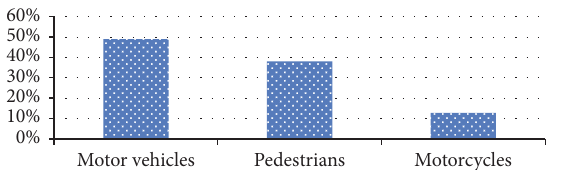
Figure 1: Distribution of persons killed and injured by road user type ( 𝑁 = 10600 ).